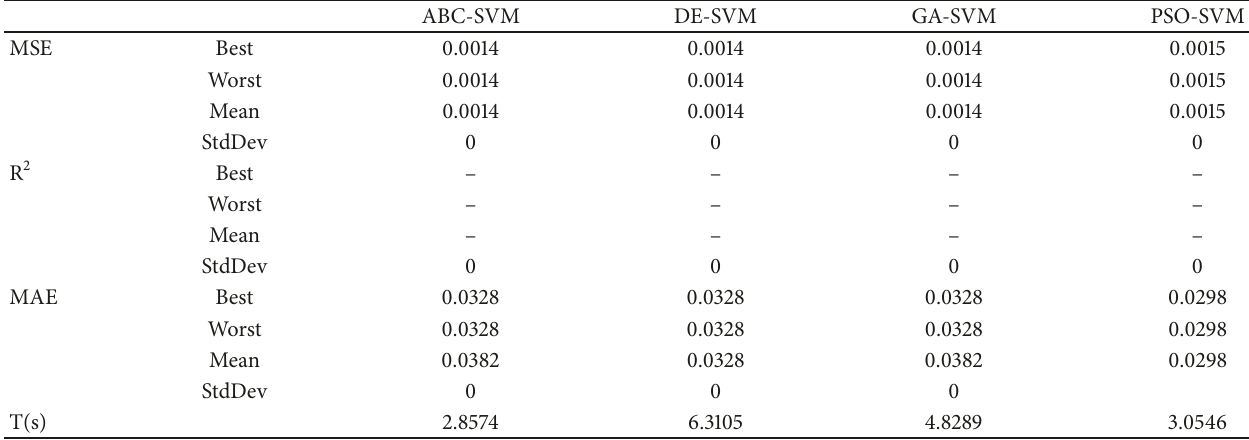
Table 5: Statistical results of 30 runs obtained by ABC-SVM, DE-SVM, GA-SVM, and PSO-SVM models for TC18 titanium alloy (The values of calculated R 2 value are small negative values, here they are replaced by the symbol